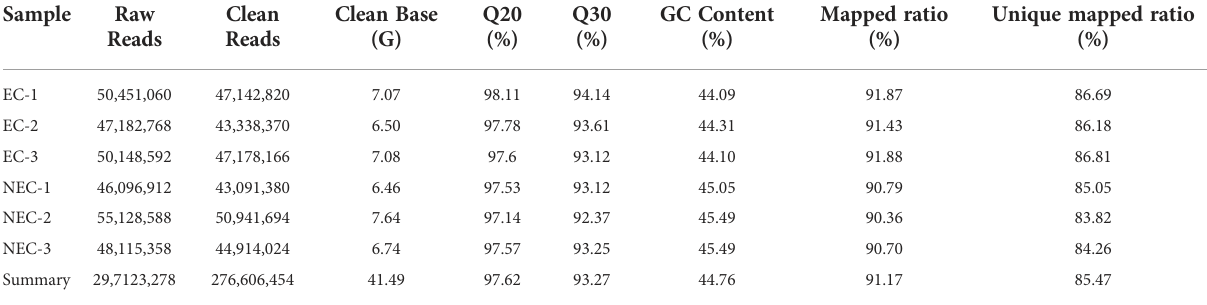
TABLE 2 Overview of transcriptome sequencing of complementary DNA from L. kaempferi callus. Sample